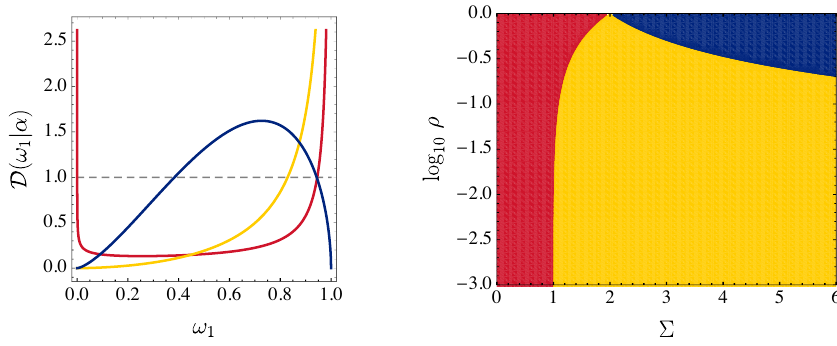
Figure 2 . (Left) Three representative Dirichlet priors for T = 2 over the unit interval drawn in di(cid:11)erent coloured full lines. The uniform prior Regions with the same prior shapes projected onto the ((cid:6) ; (cid:26) )-plane de(cid:12)ned in eq. (2.7). The distinct shape inside each colored region is represented by one distribution in the left panel with matching color